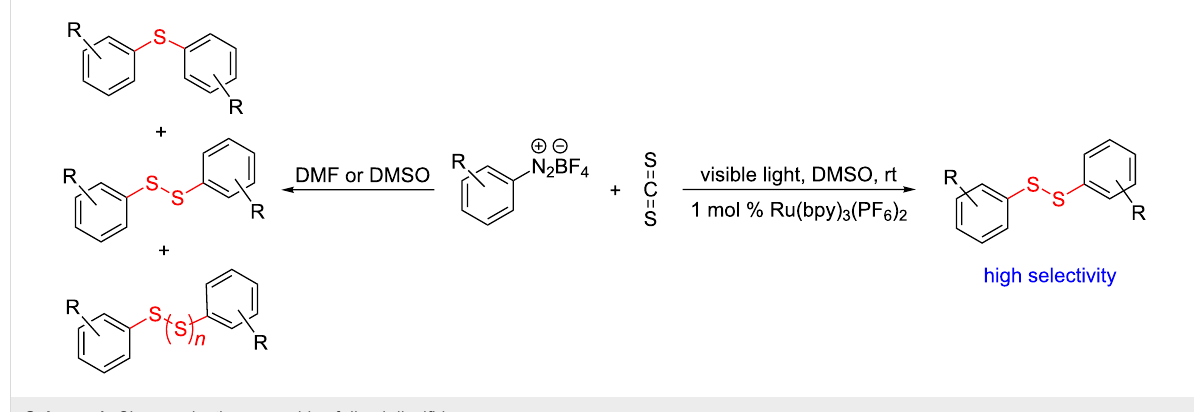
Scheme 1: Chemoselective assembly of diaryl disulfides.